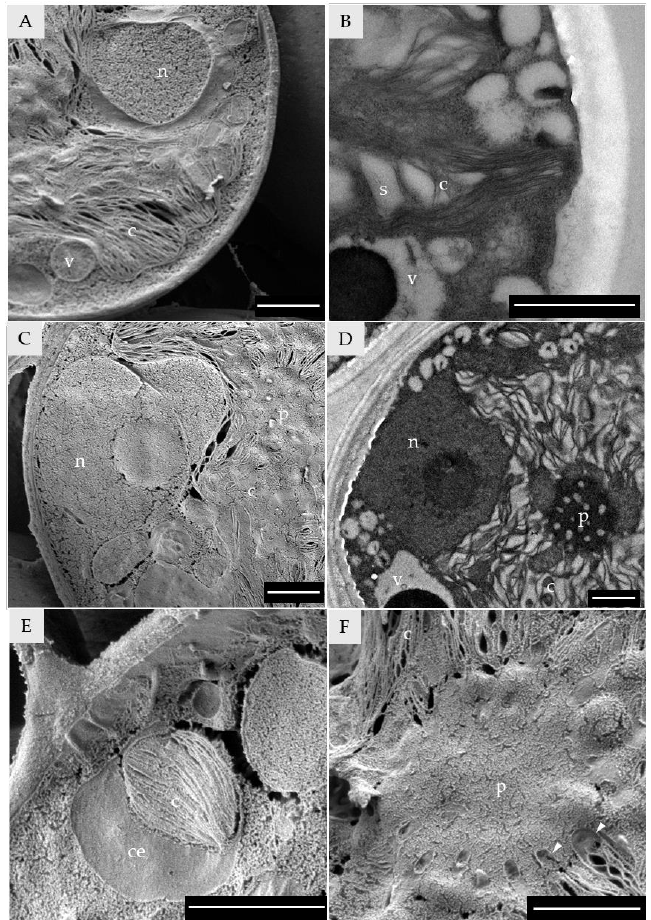
Figure 5. LTSEM ( A , C , E , F ) and TEM ( B , D ) of Trebouxia lynnae chloroplasts. ( A , B ) Chloroplast shallow lobes. ( C , D ) Chloroplast pockets. ( E ) Chloroplast lobule. ( F ) Pyrenoid. Chloroplast (c), chloroplast envelope (ce), nucleus (n), starch granules (s), vesicles (v), and pyrenoid (p) are indicated with letters. Thylakoid lamellae transitioning into pyrenotubules are indicated by a white arrowhead. Scale bars: ( A – F ) 1 µ